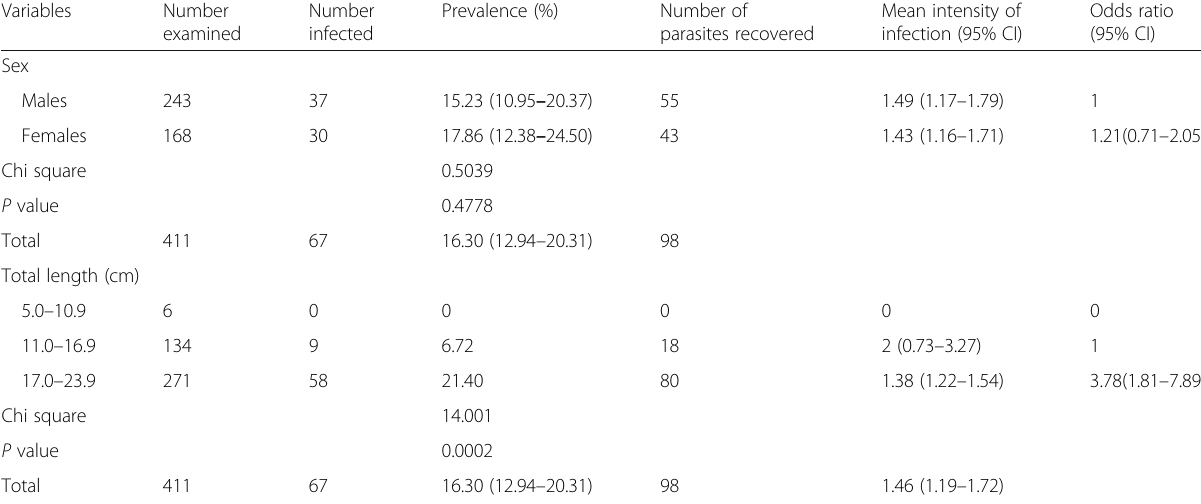
Table 2 Prevalence and intensity of infection by sex and total length